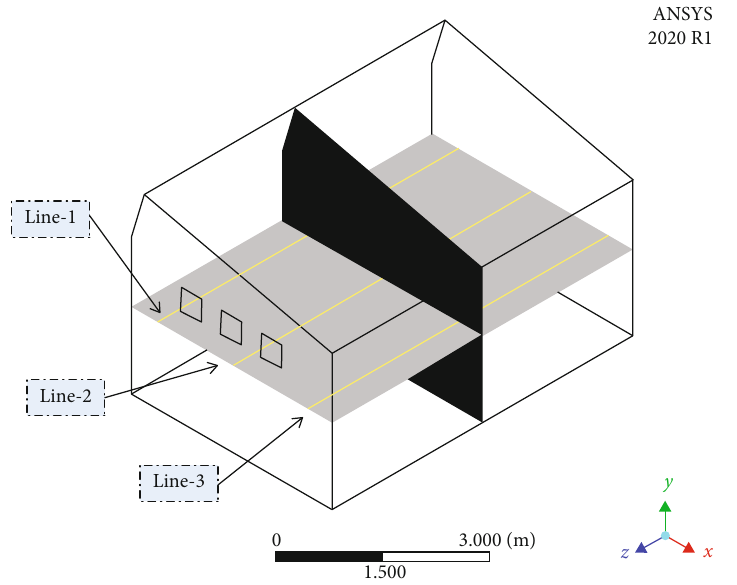
Figure 6: Selected planes (vertical and horizontal) and lines for temperature